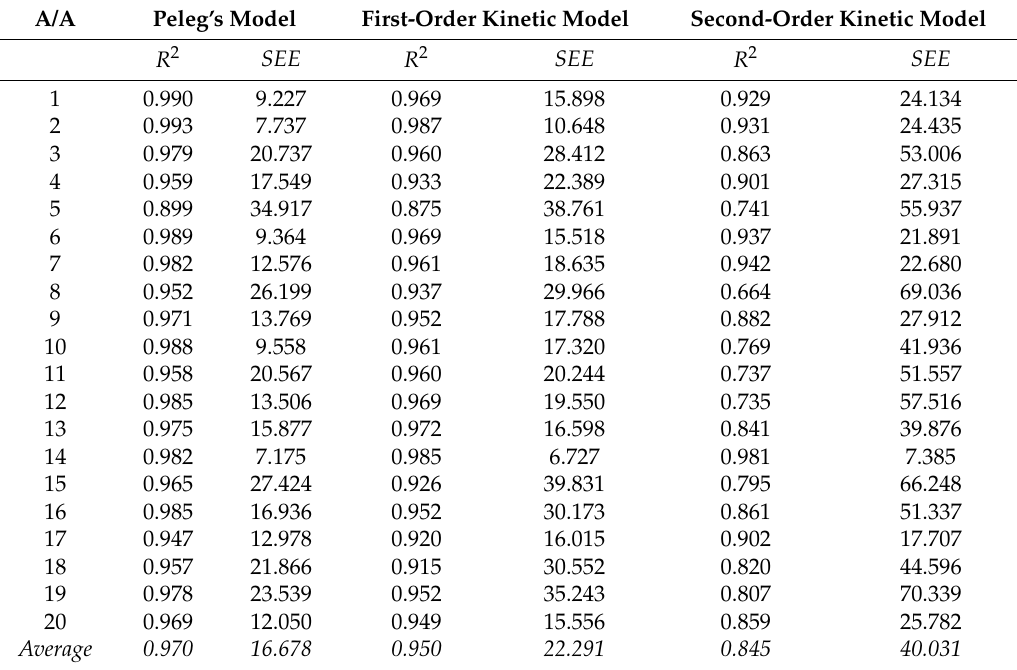
Table 3. Statistical parameters of the kinetic models for extraction of polyphenols from hemp waste.